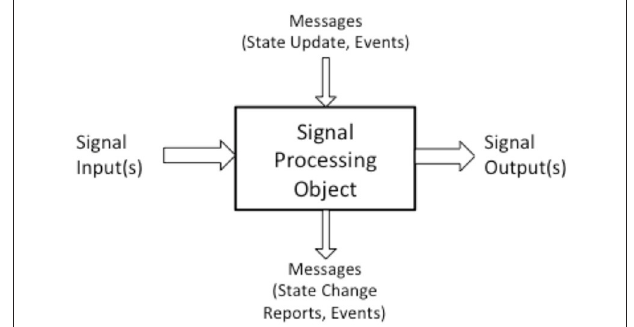
FIGURE 5 | Amatriain’s object model of signal